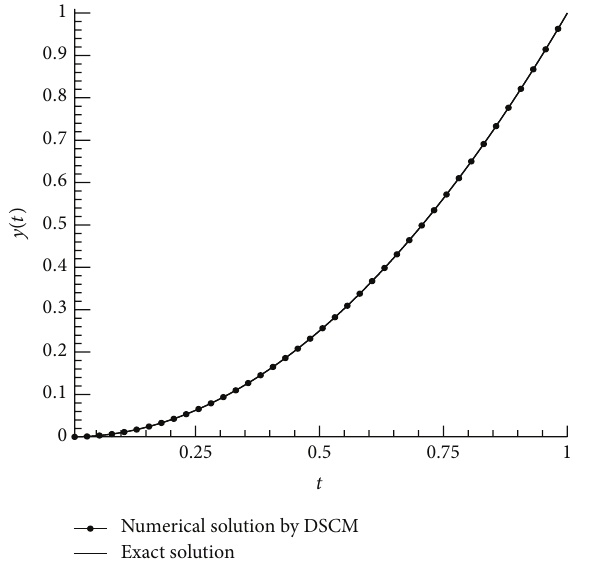
Figure 3: The error between the numerical solutions and the exact solution of Example 1; 𝛼 = 0.75